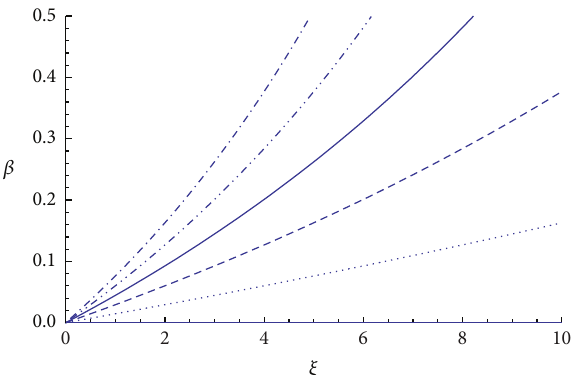
Figure 4: The asymmetry parameter 𝛽 = Λ 𝑡 /Λ 𝑟 as a function of 𝜉 for values of 𝑎 is the same as in Figure 3. In the plots, 𝑎 is increasing upwards.